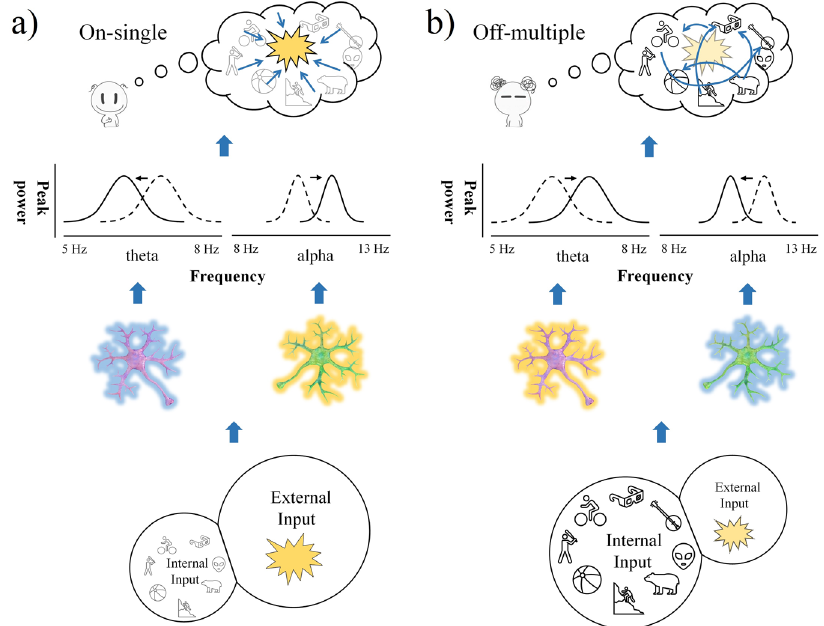
Fig. 7 Schematic illustration of the proposed mechanisms mediating the relationship between neuronal input, alpha/theta frequency sliding and thought types. a - On-single thoughts. Here during external tasks, the single external input (yellow) dominates, activates external-neurons on the population level (lower level of graph), increases alpha peak frequency, decreases theta peak frequency (middle level), and leads to the cognition of on- single thoughts (upper level). b - Off-multiple thoughts. Here, multiple internal inputs dominate during external tasks (lower level) (blue), increase theta peak frequency, decrease alpha peak frequency (middle level), and are psychologically manifest as off-multiple thoughts (upper